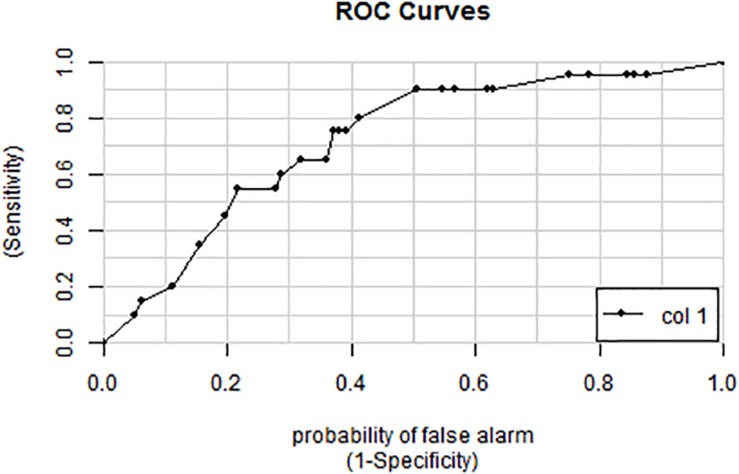
ROC curve for the breath score as a predictor of oxygen exposure. The area under the curve is 0.707 representing a 70.7% probability of predicting oxygen exposure.